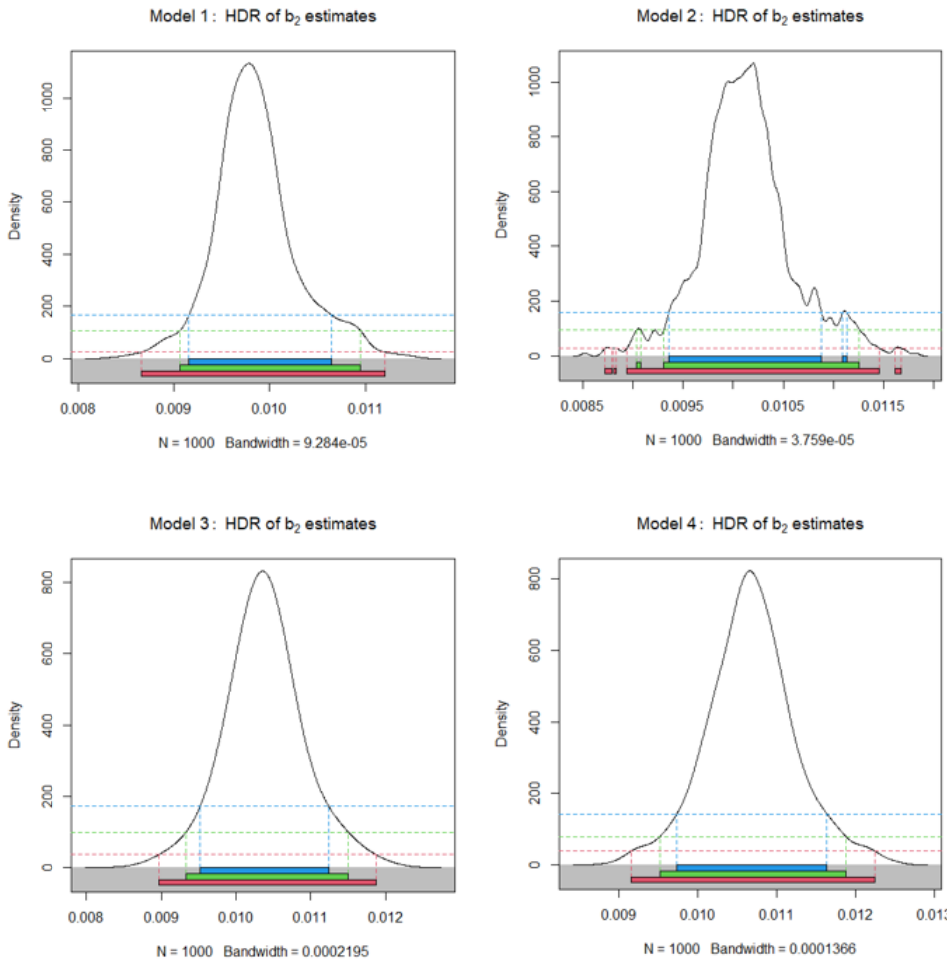
Figure 4. HDR of 𝑏 2 estimates. Model 1 to Model 4 (data from 1959 to 2019). Figure 4. HDR of b 2 estimates. Model 1 to Model 4 (data from 1959 to